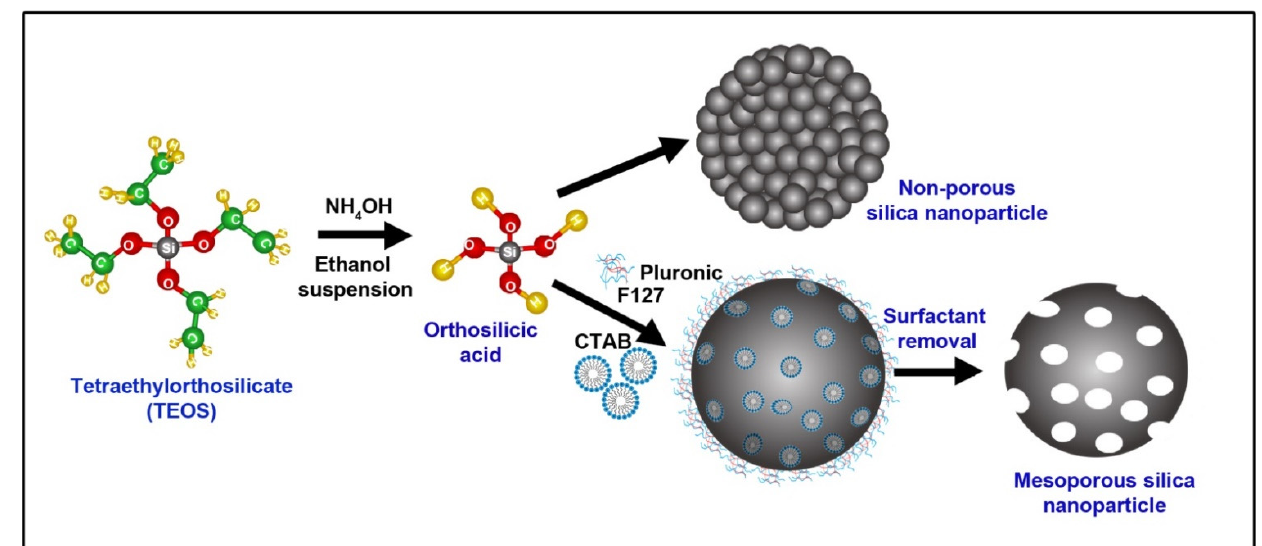
Figure 2. Schematic representation of Stöber’s method.